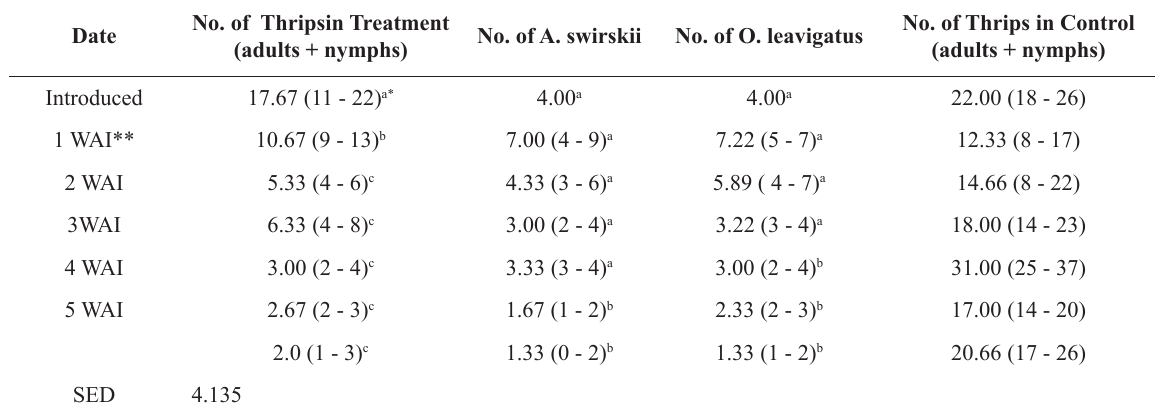
Table 1 : Mean insect count/10 leaves/plant (Average of three replicates) after introducing the biological agents; A. swirskii (SWIRSKI- MITE) and Orius leavigatus